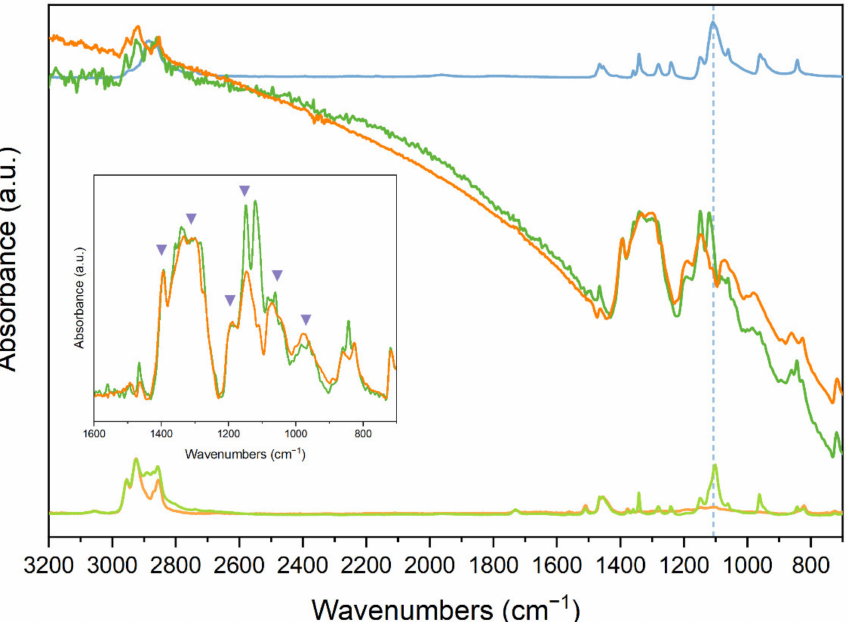
Figure 6. Infrared spectra of iodine-doped nanofibres of P3HT ( dark orange line ) and P3HT:PEO ( dark green line ); spectra have been normalised to the 1393 cm − 1 peak. The zoom inset in the IRAV bands region shows the main peaks highlighted by violet triangles. As a reference, the IR spectrum of nanofibres of pure PEO ( blue line ), of the pristine P3HT ( light orange line ), and of pristine P3HT:PEO ( light green line ) are